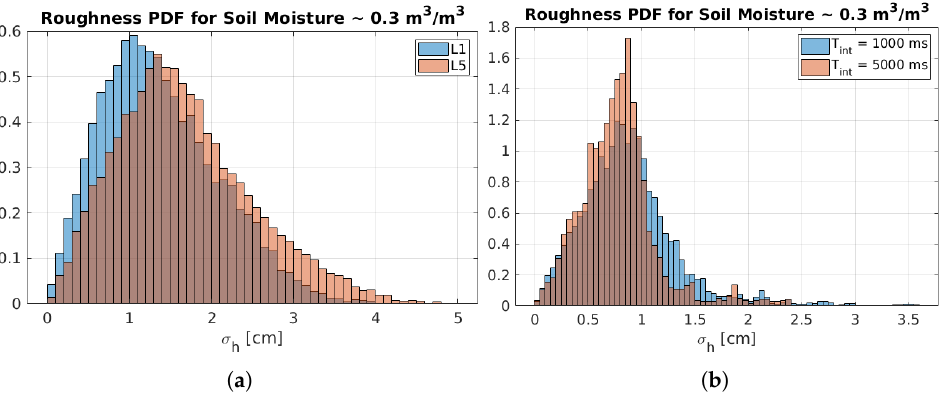
Figure 10. Estimated Surface Roughness normalized PDF in Site B during Wet flight seen by L1 and L5 signals, assuming a flat reflectivity Γ = − 5 dB, and using ( a ) T int = 20 ms, and ( b ) at T int = 1000 ms and 5000 ms only for the L1